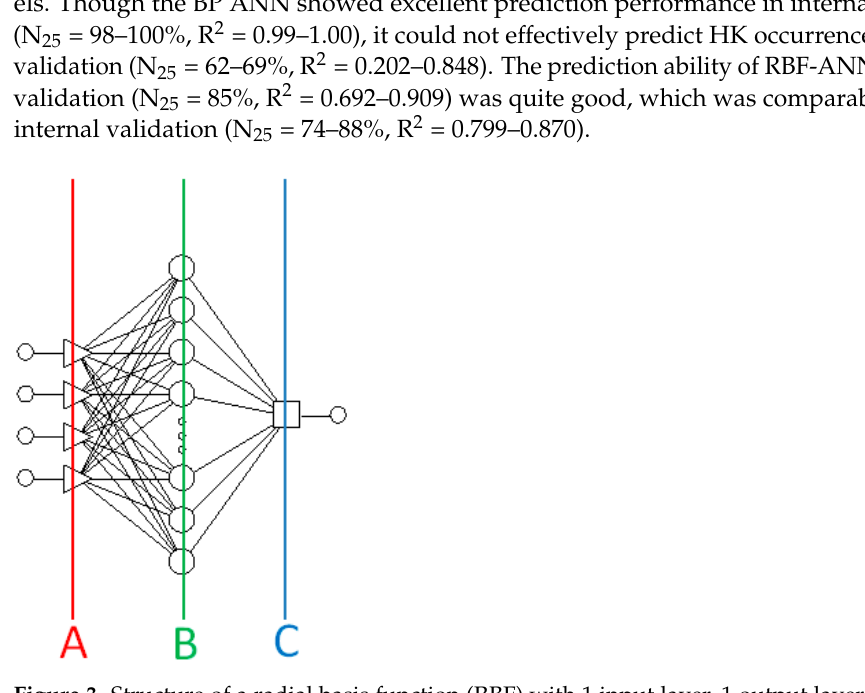
Figure 3. Structure of a radial basis function (RBF) with 1 input layer, 1 output layer, and 1 radial hidden layer: A—input layer, B—hidden layer, C—output layer